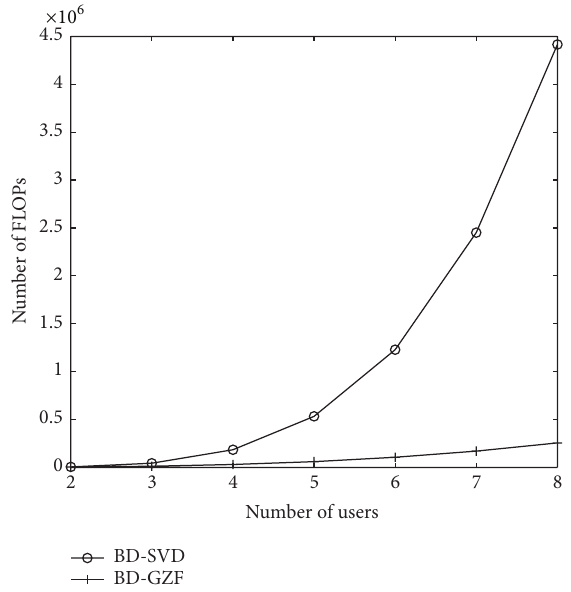
Figure 2: Complexity comparison with 𝑁 𝑘 = 2 and 𝑁 𝑇 = 𝑁 𝑆 = × 𝐾 𝑁 𝑘